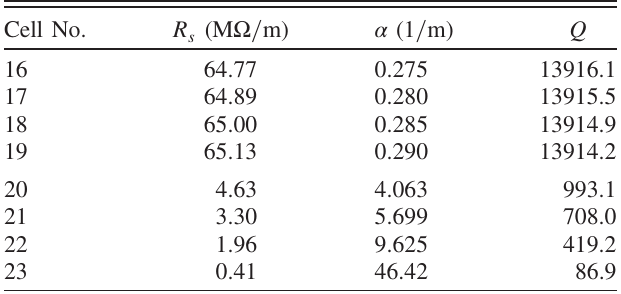
TABLE I. Characteristic parameters of the last 4 normal cells and the load